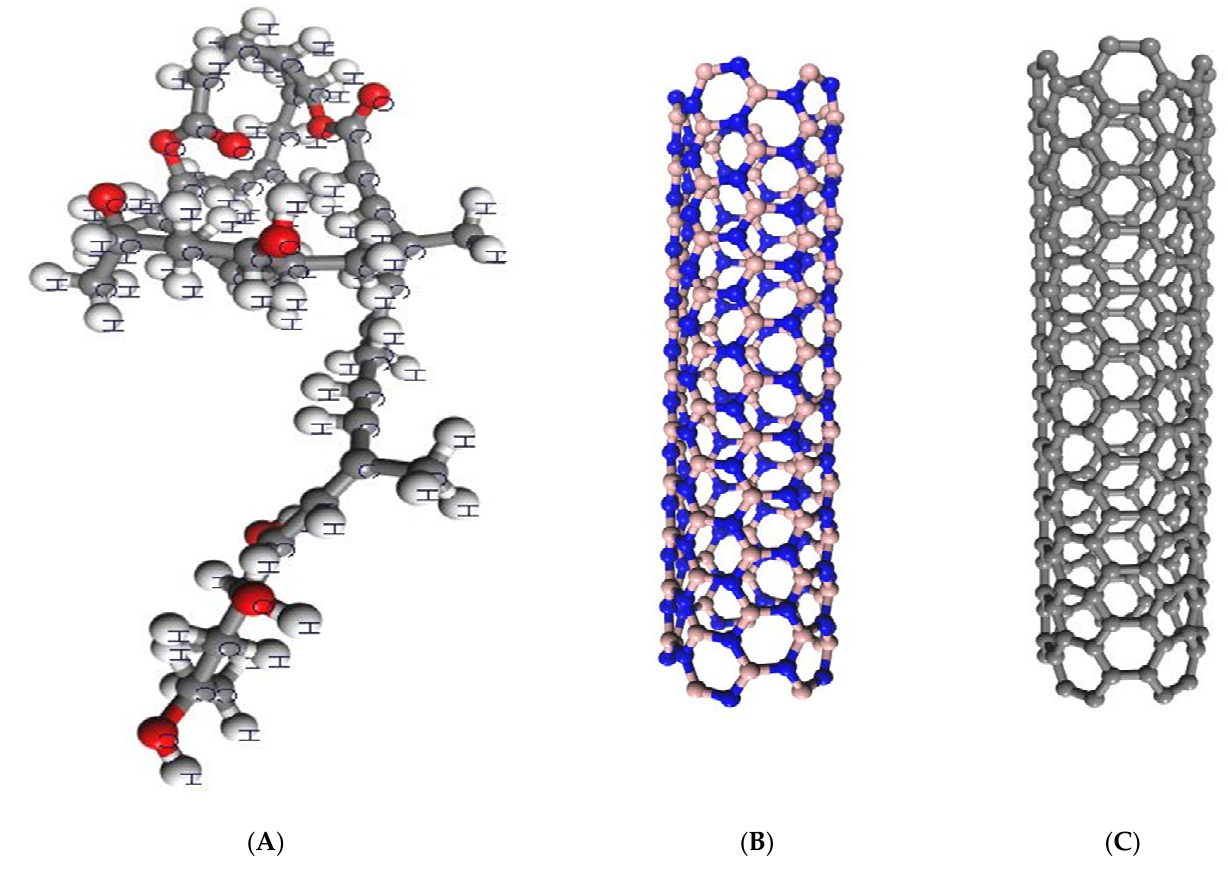
Figure 1. Optimized structures of mycolactone, armchair BNNT (5,5), and armchair CNT (5,5). ( A ) the optimized structure of mycolactone, ( B ) the structure of armchair BNNT (5,5), and ( C ) the structure of armchair CNT (5,5). Carbon, boron, and nitrogen are represented by grey, brown, and blue, respectively.